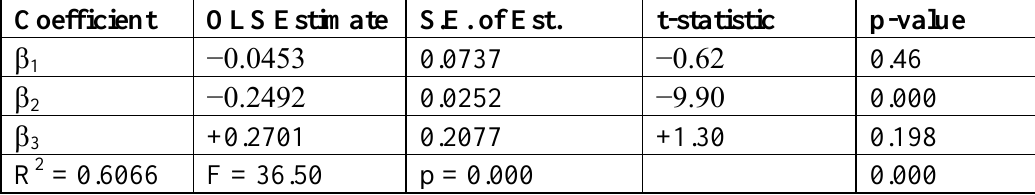
Table 3. OLS Estimates of Model Equation (5) 1 .